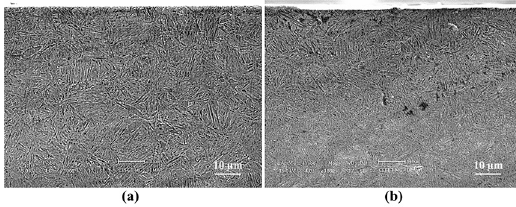
Figure 6. Micrographs of samples grinded with Mix 1 (A) and Mix 2 (B).